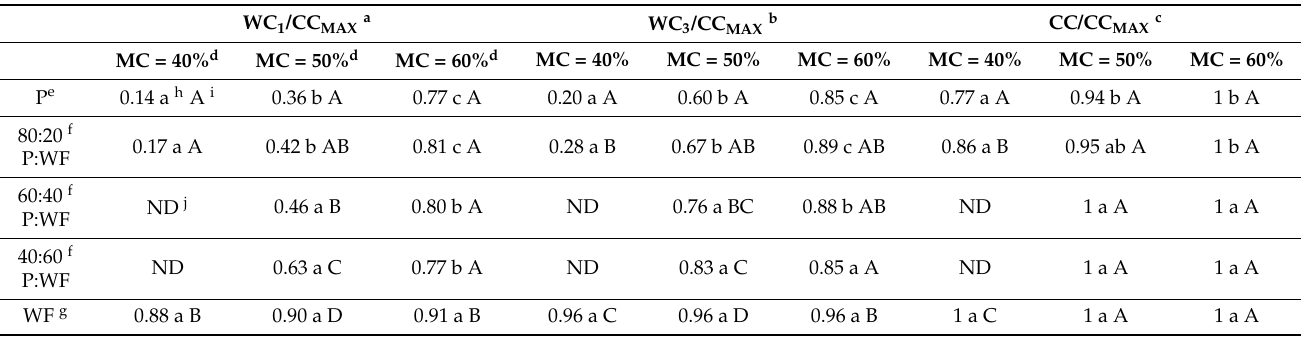
Table 3. Values of the WC 1 /CCMAX, WC 3 /CCMAX and CC/CCMAX ratios, depending on the initial moisture